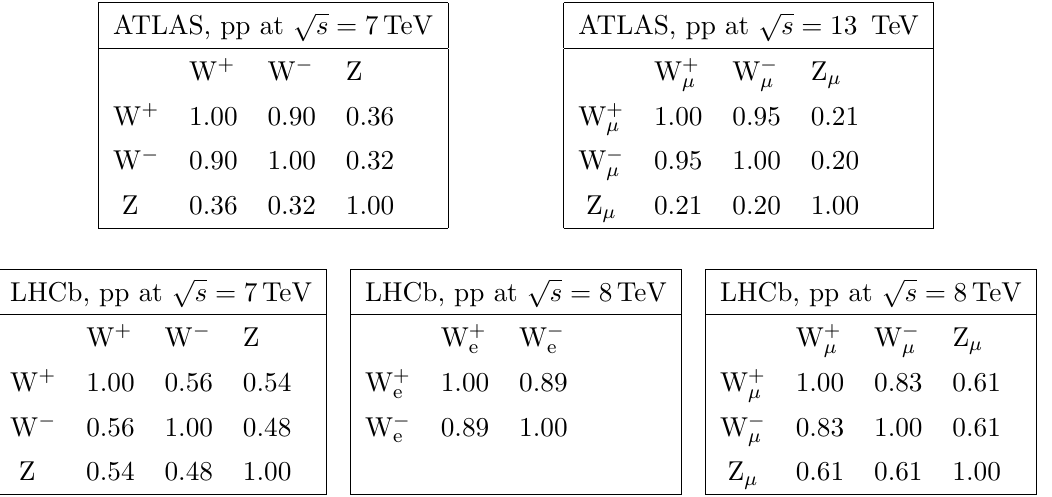
Table 12 . Correlation matrices among the systematic uncertainties of di(cid:11)erent W + , W (cid:0) , and Z boson cross section measurements in ATLAS [7{9] and LHCb [10{13] as derived, in some cases using eq. (6.1), from the corresponding experimental